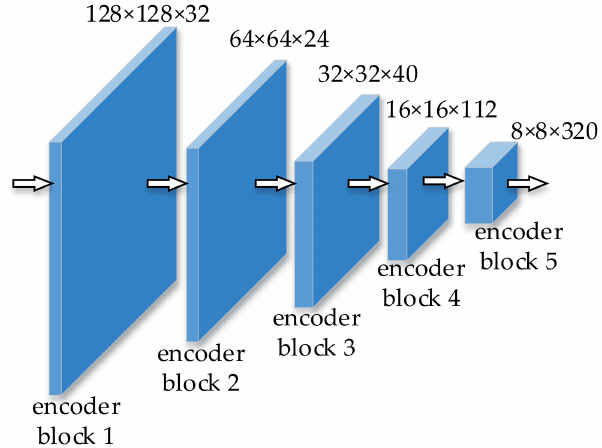
Figure 3. Encoder structure in the proposed